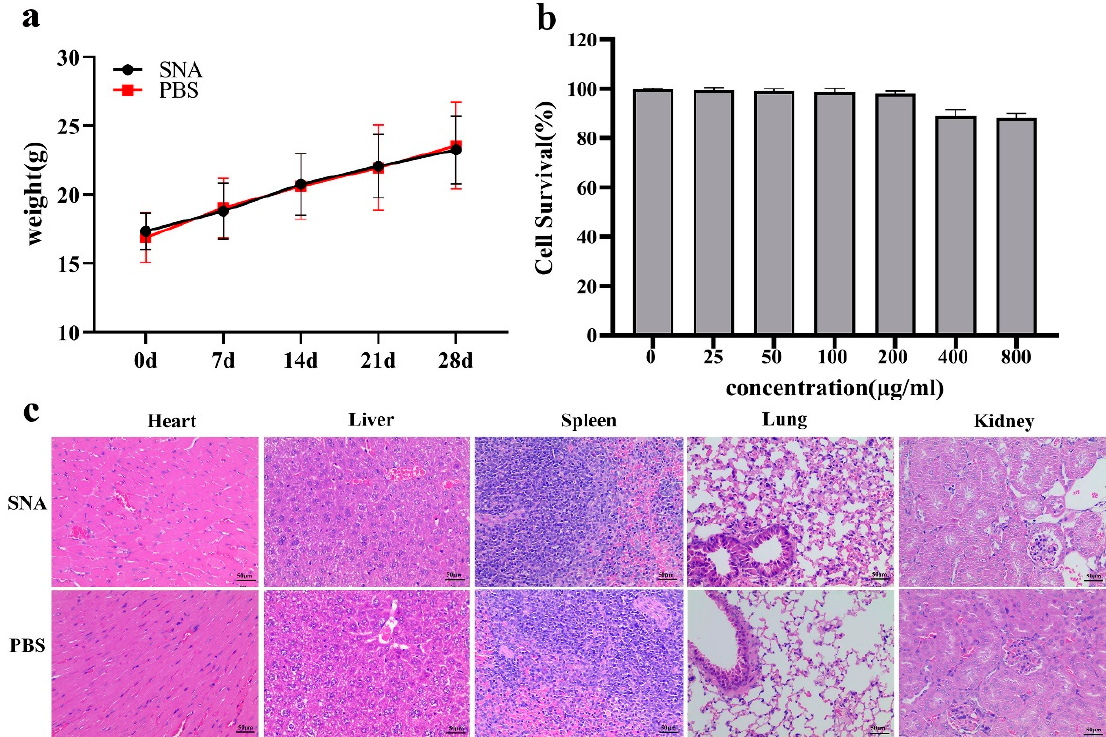
Figure 5. Safety evaluation of the SNA adjuvants. ( a ) The body weight of the immunized mice at 0, 7, 14, 21, and 28 days after immunization. ( b ) The cytotoxicity of different concentration of SNA on the PK-15 cells. ( c ) Histopathological changes in the heart, liver, spleen, lung and kidney of mice after intramuscular injection of SNA and PBS.